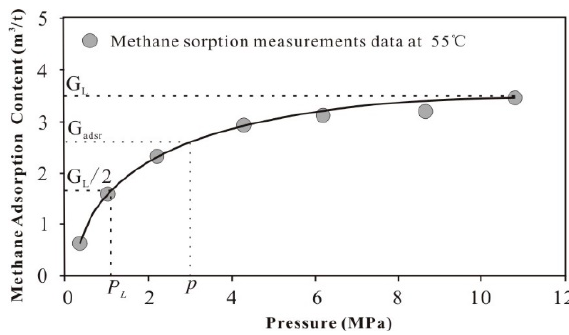
Figure 9. The calculation of adsorption shale gas content by the Langmuir model.